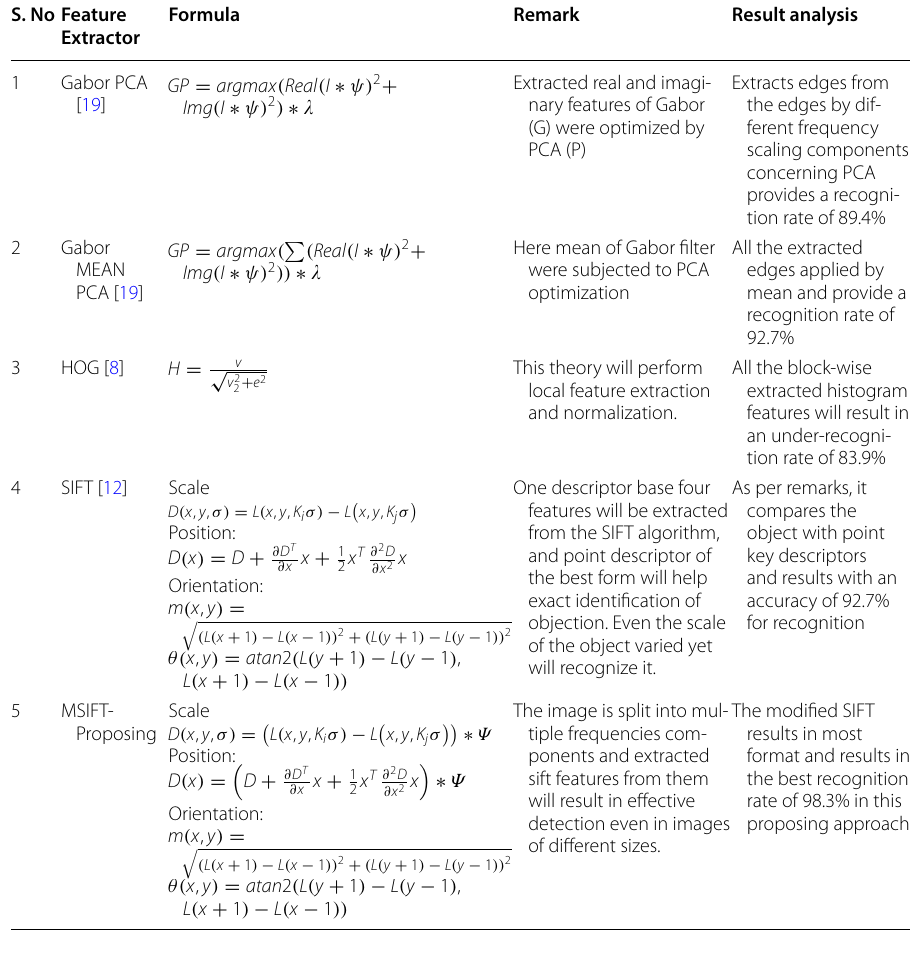
Table 1 Different feature extraction algorithms on FERET data sets S. No Feature